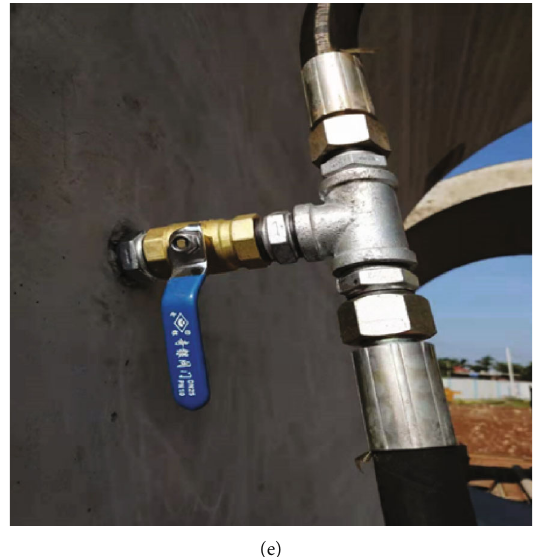
Figure 7: Site view of slurry grouting system and pipe jacking. (a) The head of pipe jacking machine. (b) Circulation slurry discharge in head. (c) Slurry synchronous grouting on segment. (d) Prefabricated grouting hole on each segment and the branch grouting pipe. (e) Ball valve